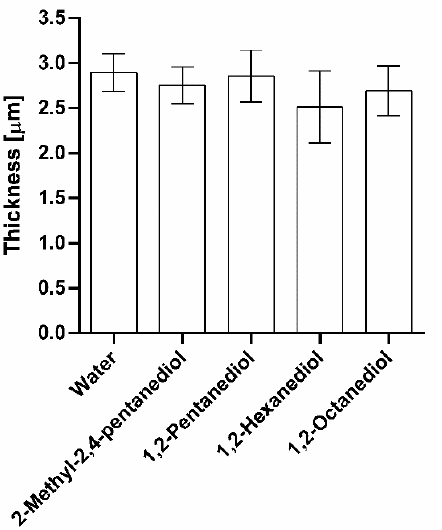
Figure 7. Measured thicknesses of SC after treatment with water and 5% solutions of 2-methyl-2,4-pentanediol, 1,2-pentanediol and 1,2-hexanediol, and saturated 1,2-octanediol solution, n = 9, mean ± SD.